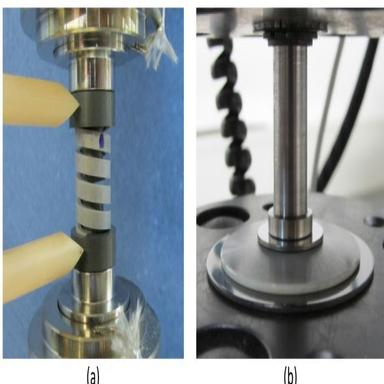
Cyclic fatigue test setup for (a) helical compression springs and (b) disk springs.